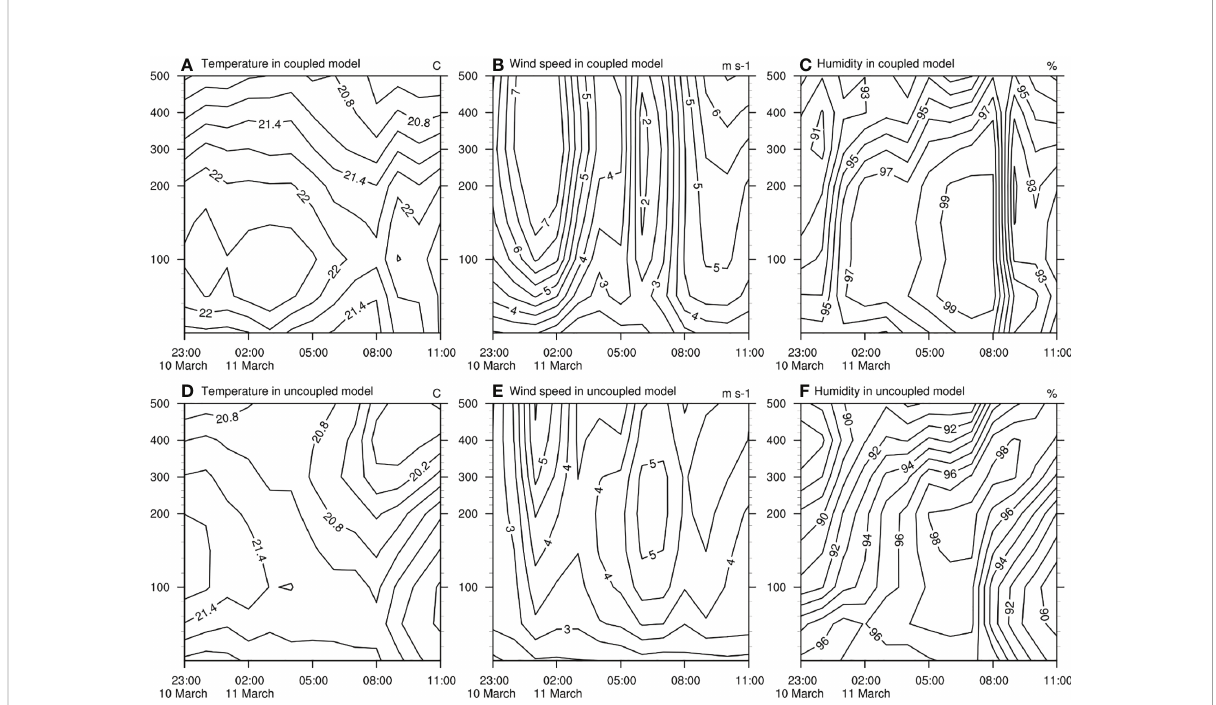
FIGURE 10 Vertical time pro fi les of (A) air temperature ( ℃ ), (B) horizontal wind speed (m·s -1 ), and (C) relative humidity (%) average value over the target area (marked by the black rectangular frame in Figure 7) at 0200BJT (black), 0500BJT (green), and 0900BJT (red) for the coupled model. (D – F) same as (A – C) , but for the uncoupled